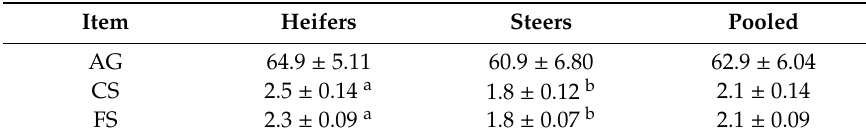
Table 2. Mean ( ± SEM) agitometer score (AG), crush score (CS) s, and flight speed (FS, m / s) for heifers, steers, and pooled